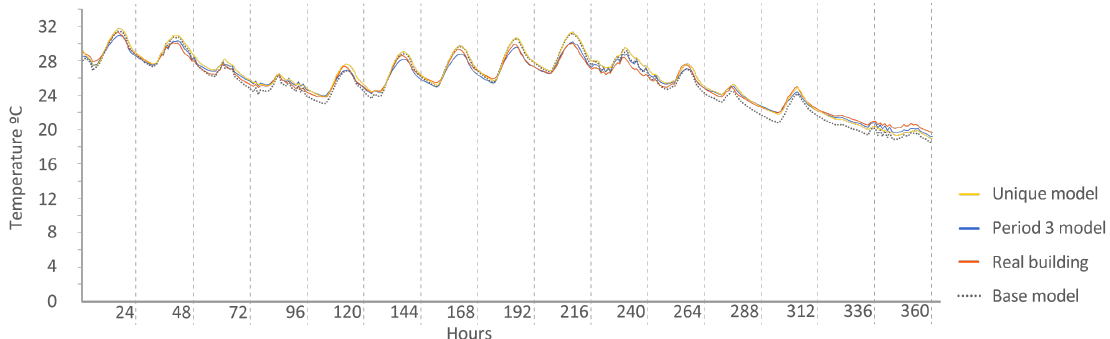
Figure 18. Temperature in house O5, Period 3 (ROLBS). Period 3 model: CV(RMSE): 1.26%, NMBE: 0.13%, and R 2 : 98.69%. Base model: CV(RMSE): 2.51%, NMBE: 0.83%, and R 2 : 98.73%. Unique model: CV(RMSE): 2.19%, NMBE: − 0.97%, and R 2 : 98.59%.